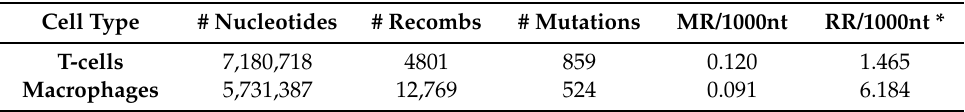
Figure 2. Recombination and mutation rates in T ‐ cells and macrophages. Both panels show estimated rates and 95% confidence intervals. Table 2. Results from experimental infections. Table 2. Results from experimental infections.